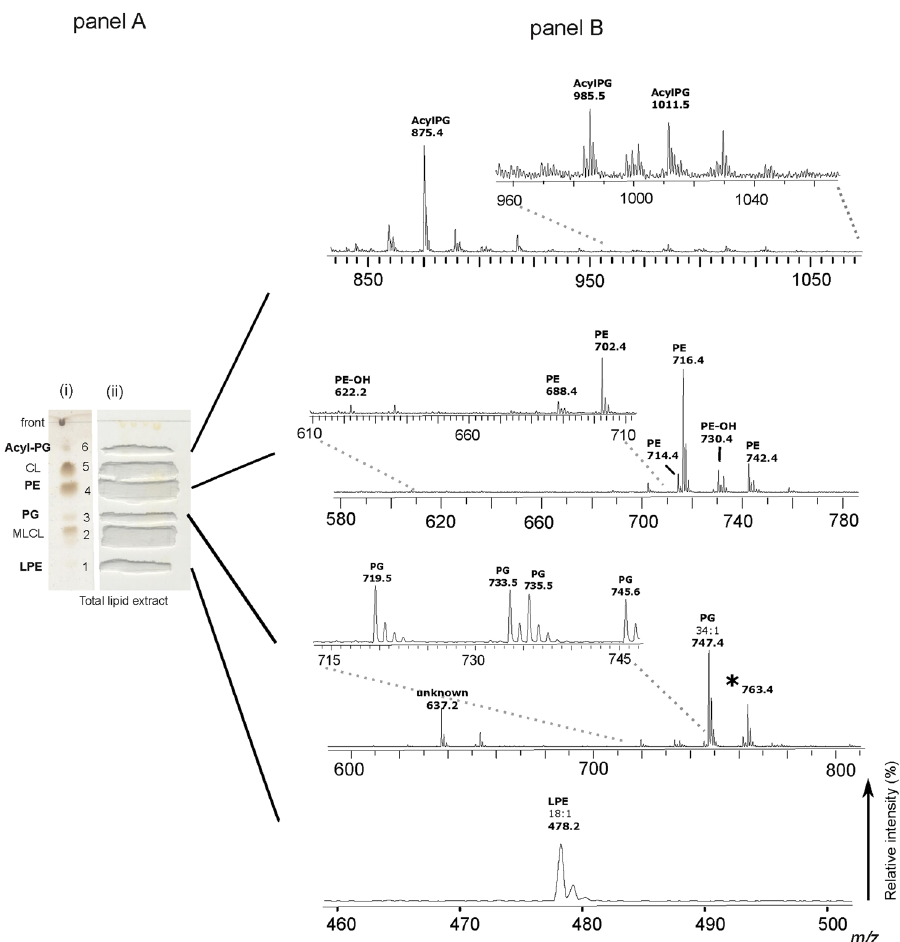
Figure 3. MALDI-TOF/MS analyses of lipid bands #1, 3, 4 and 6, isolated from the total lipid extract of A . baumannii by TLC. The total lipid extract of A . baumannii cells was loaded on the plate (160 μ g per each lane). One lane was sprayed with sulfuric acid and charred in the oven (permanent staining of all class of lipids) (i); the other lanes were stained with iodine vapors (temporary staining of all class of lipids) (ii); each band was marked with a pencil and silica was scraped in correspondence of lipid bands. The chromatography plate is shown in panel A. Lipid bands #1, 3, 4 and 6 were extracted from silica and were analyzed by MALDI-TOF/ MS. The MALDI/TOF-MS (negative ion mode) spectra of the four lipid bands corresponding to Acyl-PGs, PE, PG and LPE (from the top to the bottom) are shown in panel B. The detailed list of detected peaks is shown in Table 1. The peak at m/z 763.4 labeled with star has not been included in the list because it results from TLC